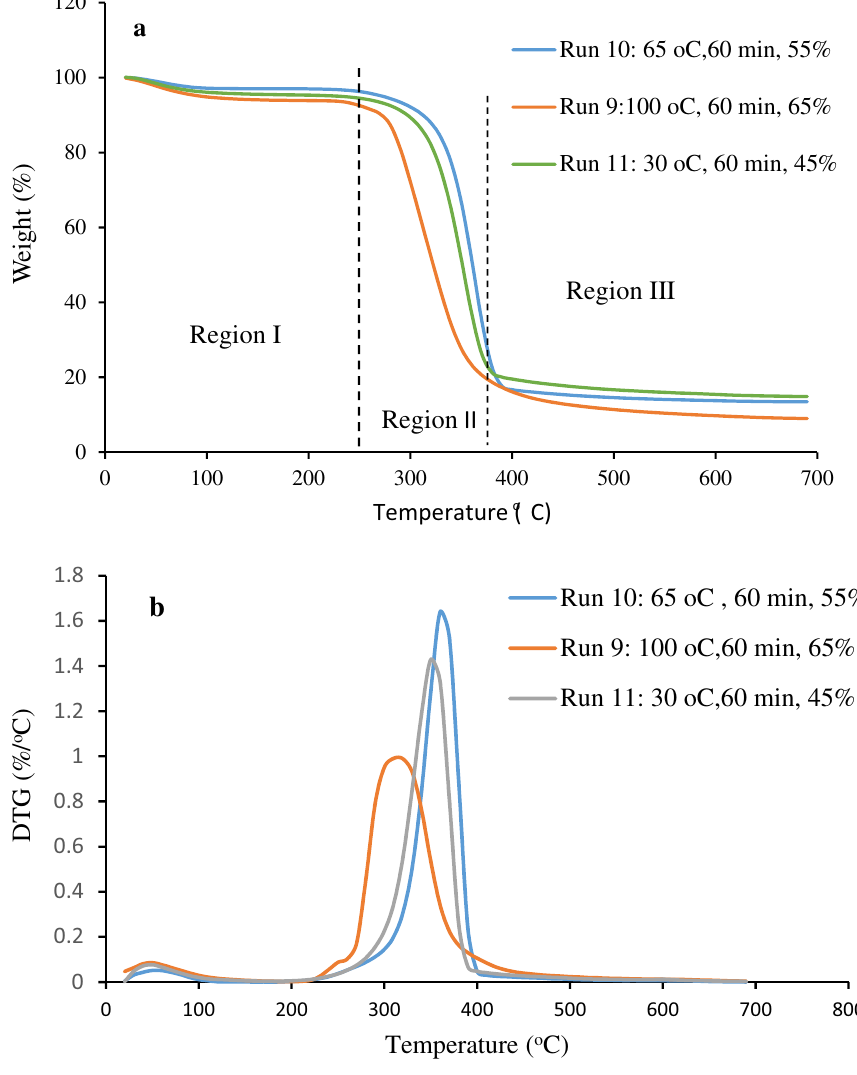
Figure 5. ( a ) TGA ( b ) derivative thermogravimetric (DTG) curves of CNCs at different operating